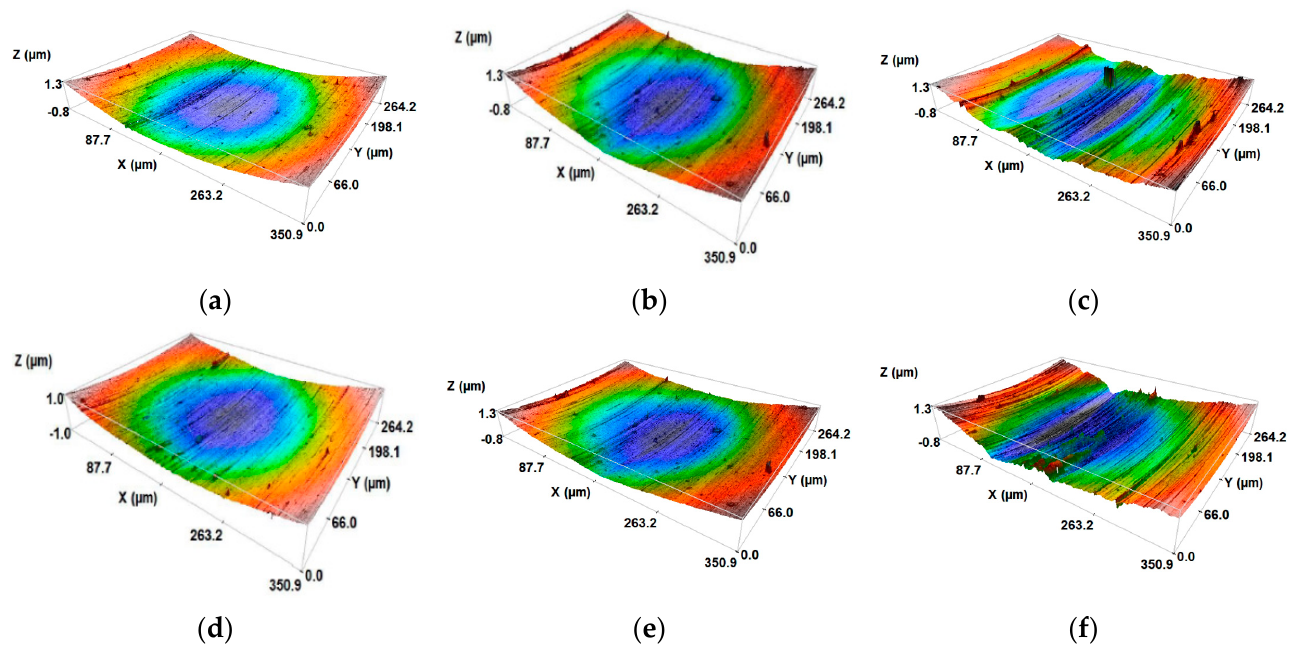
Figure 5. 3D topography of the analyzed craters. 500 cycles with: ( a ) Slurry concentration 25 g/100 mL, ( b ) Slurry concentration 35 g/100 mL, ( c ) Slurry concentration 45 g/100 mL, and 1500 cycles with: ( d ) Slurry concentration 25 g/100 mL, ( e ) Slurry concentration 35 g/100 mL, ( f ) Slurry concen- tration 45 g/100 mL.